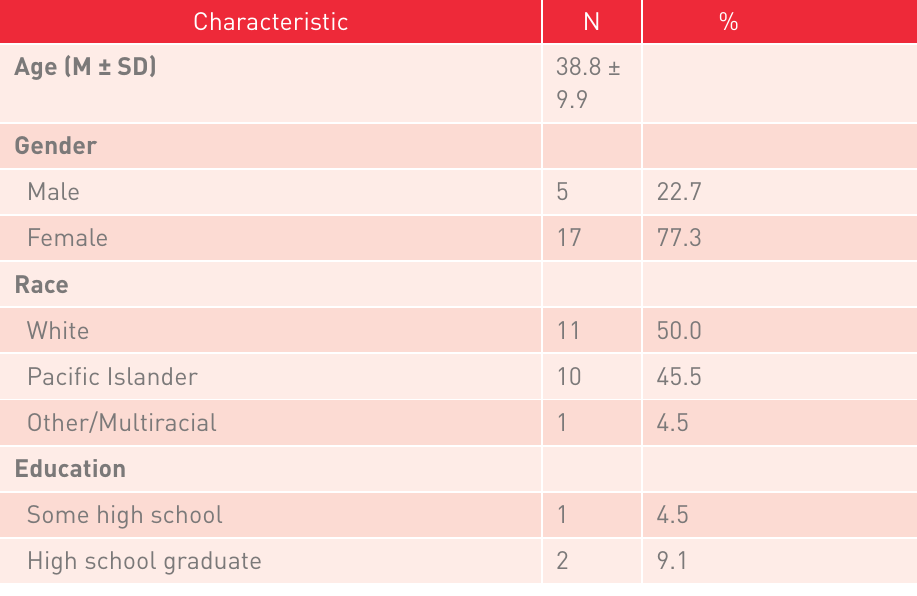
Participant Demographics